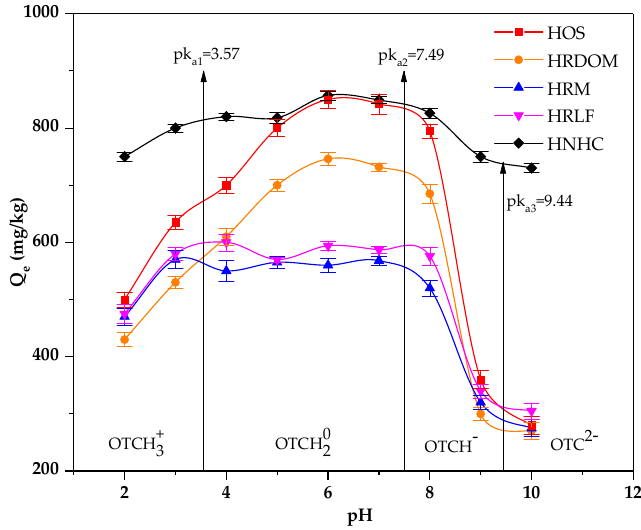
Figure 4. The e ff ect of pH on the adsorption of OTC by di ff erent Figure 4. The effect of pH on the adsorption of OTC by different fractions